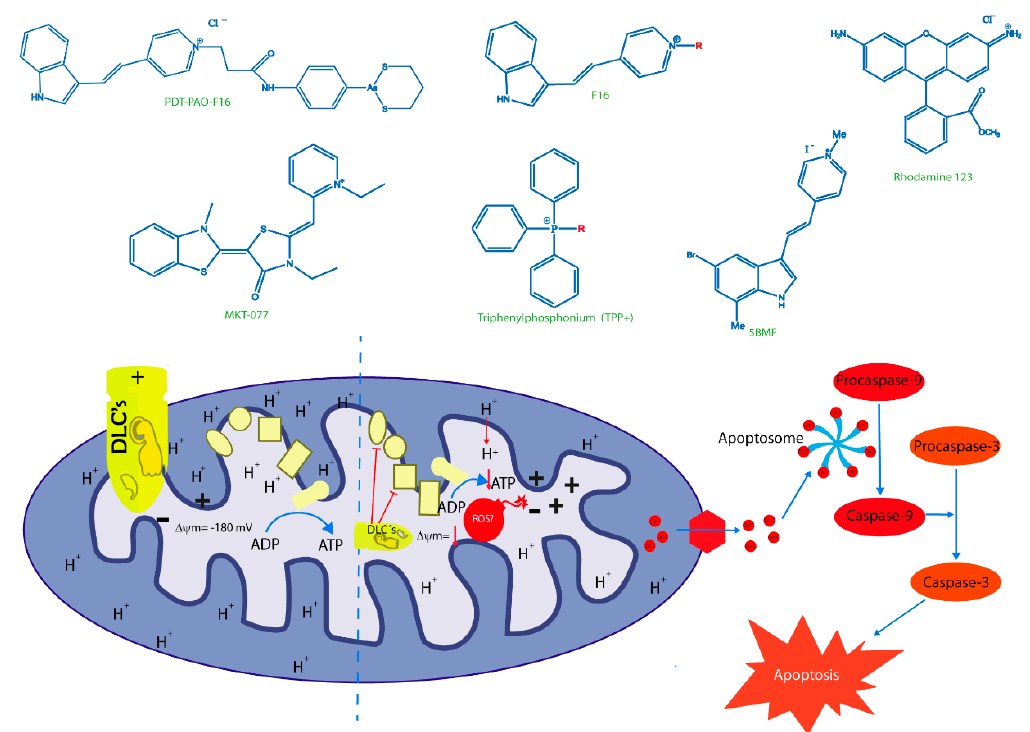
Figure 2. Principal delocalized lipophilic cations (DLCs) and their mechanism of action. The figure shows the chemical structures of classic lipophilic cations as Rhodamine 123, TPP + and MKT-077. Additionally, the chemical structures of novel DLCs, such as 5BMF, F16 and their derivative PDT-PAO-F16, are shown. Lower section shows ∆Ψ m as the attraction force that allows all DLCs to reach tumor cell mitochondria and their respective targets described for each of them. The final e ff ect of mitochondrial malfunctions induced by DLCs is cell death, principally through apoptosis. + positive charge in mitochondrial intermembrane space; ( − ) negative charge on the matrix side of the inner mitochondrial membrane; red arrows: H + transposed from intermembrane space to mitochondrial matrix and a decrease in mitochondrial transmembrane potential; inhibitory red lines: inhibitory e ff ects of delocalized lipophilic